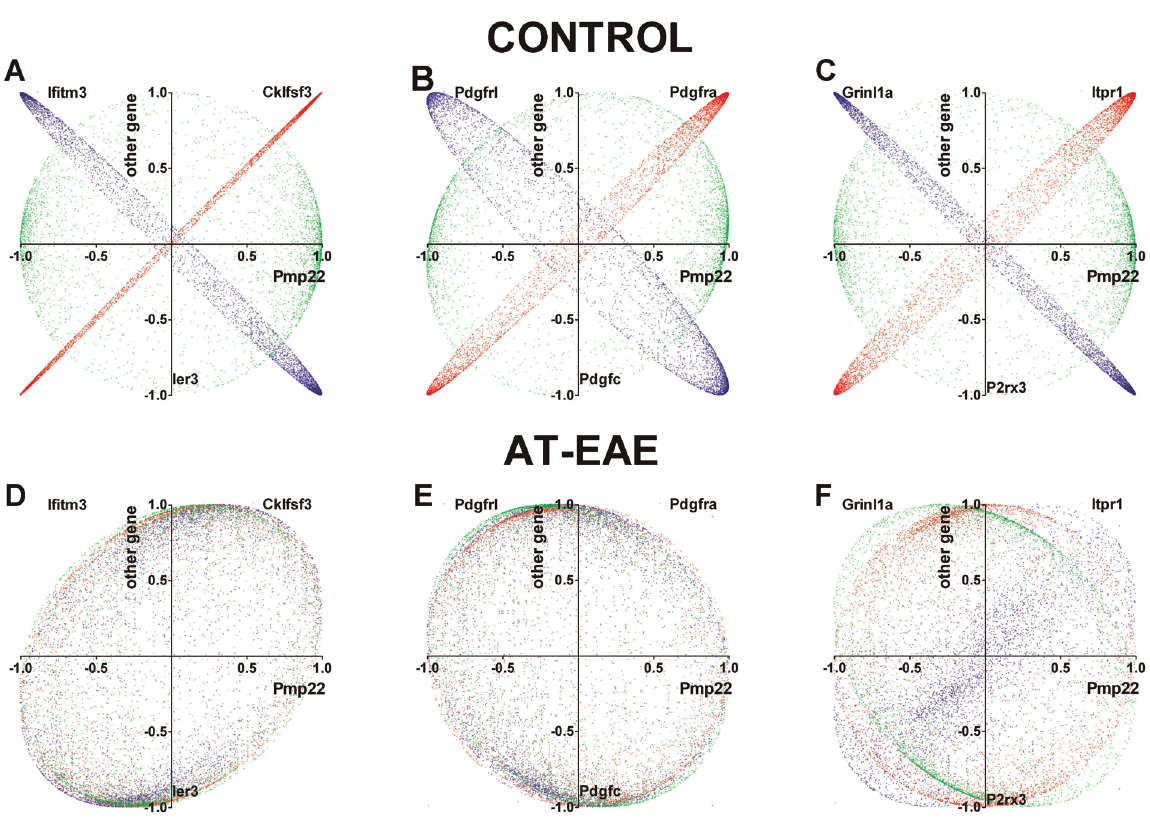
Figure 5. See-saw partners of peripheral myelin protein (Pmp22) in control spinal cord and alteration by AT-EAE. ( A and D ) Immune response partners. ( B and E ) Platelet derived growth factors. ( C and F ) Calcium signaling genes. The correlation coefficients of the indicated genes with each other gene were plotted against those of Pmp22 with each other gene. In controls, red color indicates likeness, green neutrality, and blue opposition. The table presents the overlap (OVL) of the coordination profiles in both conditions. Note that the AT-EAE turned the significant similarity and opposition of the coordination profiles into neutrality. Cklfsf3, chemokine-like factor super family 3; Ifitm3, interferon-induced transmembrane protein 3; Ier3, immediate early response 3; Pdgfra, platelet derived growth factor receptor, alpha polypeptide; Pdfrl, platelet-derived growth factor, receptor-like; Pdgfc, platelet-derived growth factor, C polypeptide; Itpr1, inositol 1,4,5-triphosphate receptor 1; Grinl1a, glutamate receptor, ionotropic, N-methyl D-aspartate-like 1A; P2rx3, purinergic receptor P2X, ligand-gated ion channel, 3. The overlap scores (OVL) of the Pmp22 in the two conditions